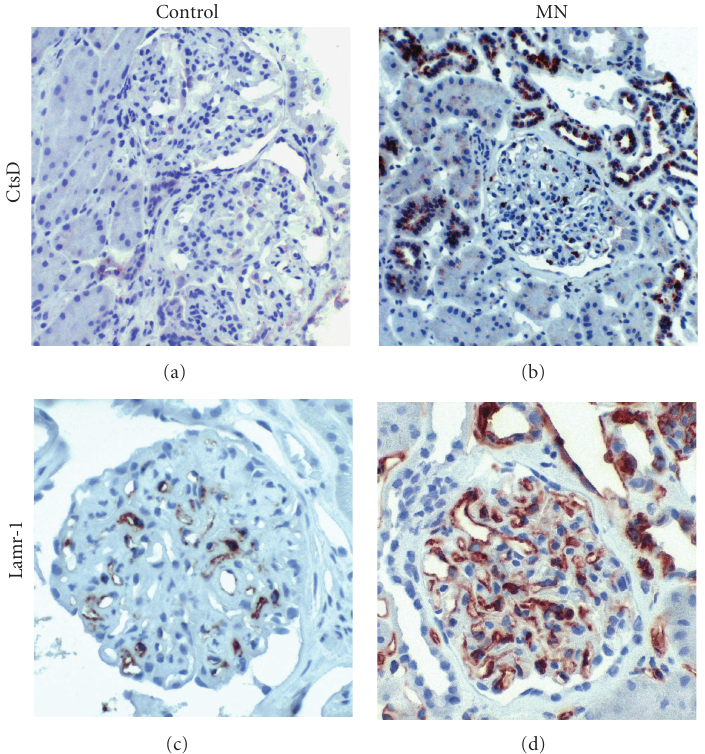
Figure 7: Renal immunohistochemistry of candidate proteins in human kidneys. Kidneys from humans of the normal control group (a and c) and membranous nephropathy group (b and d) were stained for CtsD (a and b) and Lamr-1 (c and d). All images are at 400x magnification. CtsD: cathepsin D; Lamr-1: laminin